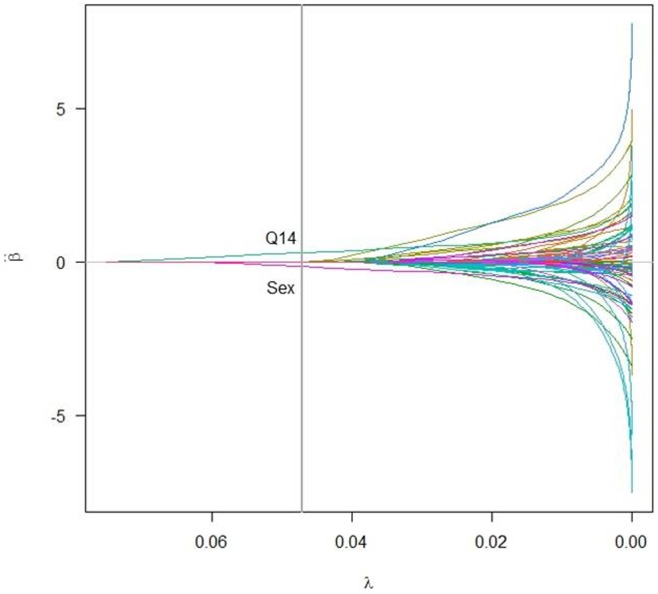
The path of the estimated coefficients over a grid of values for , and a group of covariates including Sex and Q14 corresponding to  = 0.0471 was selected.Sex: The sex of child. Q14: Whether there are e-waste piles or recycling workshops within fifty meters around the house.